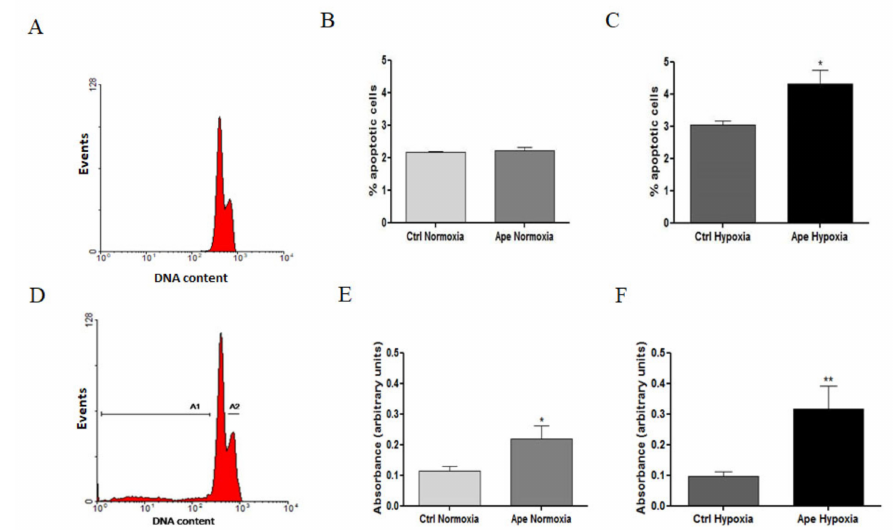
Figure 7. ( A ) FACS analysis of propidium iodide stained GB7 cells, showing the presence of the hypodiploid DNA content in hypoxia condition (subG1 phase; A1); ( B ) and ( C ) Percentage of apoptotic cells obtained by measuring the fraction of cells with hypodiploid DNA content in normoxia and hypoxia, and in presence or absence of 100 µ M Ape (24h). ( E ) and ( F ) Levels of lactic acid dehydrogenase (LDH) activity in culture media of GB7 cells maintained in normoxia and hypoxia and in presence or absence of 100 µ M Ape (24 h). The data are the mean ± SEM of the three independent experiments performed in duplicate ( t -test;* p < 0.05; ** p <